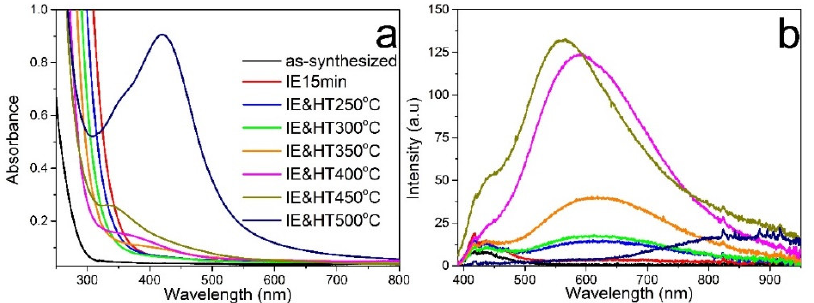
Figure 15. Absorbance ( a ) and emission spectra ( b ) of PTR-Sb10 glass samples as-synthesized, ion- exchanged, and heat-treated after the IE process at different time for 15 h. The excitation wavelength was 350 nm.